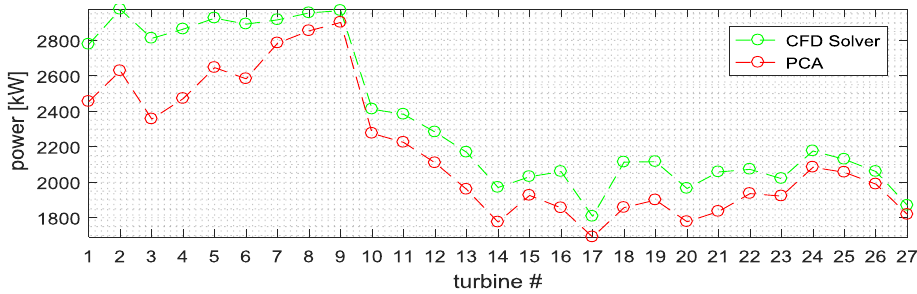
Figure 8. Comparison between spatial power output obtained from CFD solver output (green) and obtained by using of PCA for the 2nd forecasting hour.